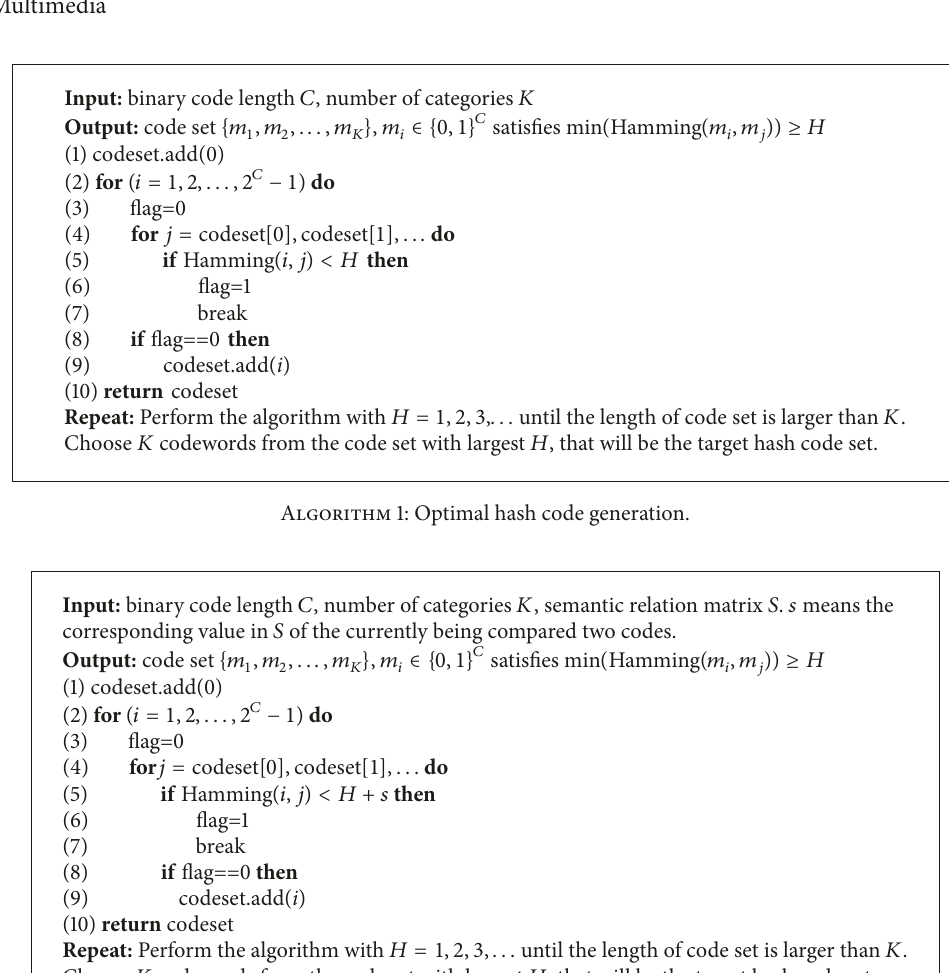
Algorithm 2: Uneven semantic optimal hash code generation.